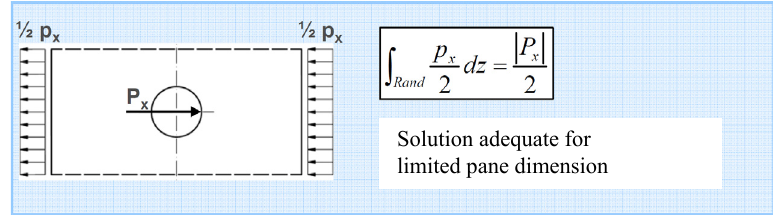
Figure 5: Basic stress state 1.